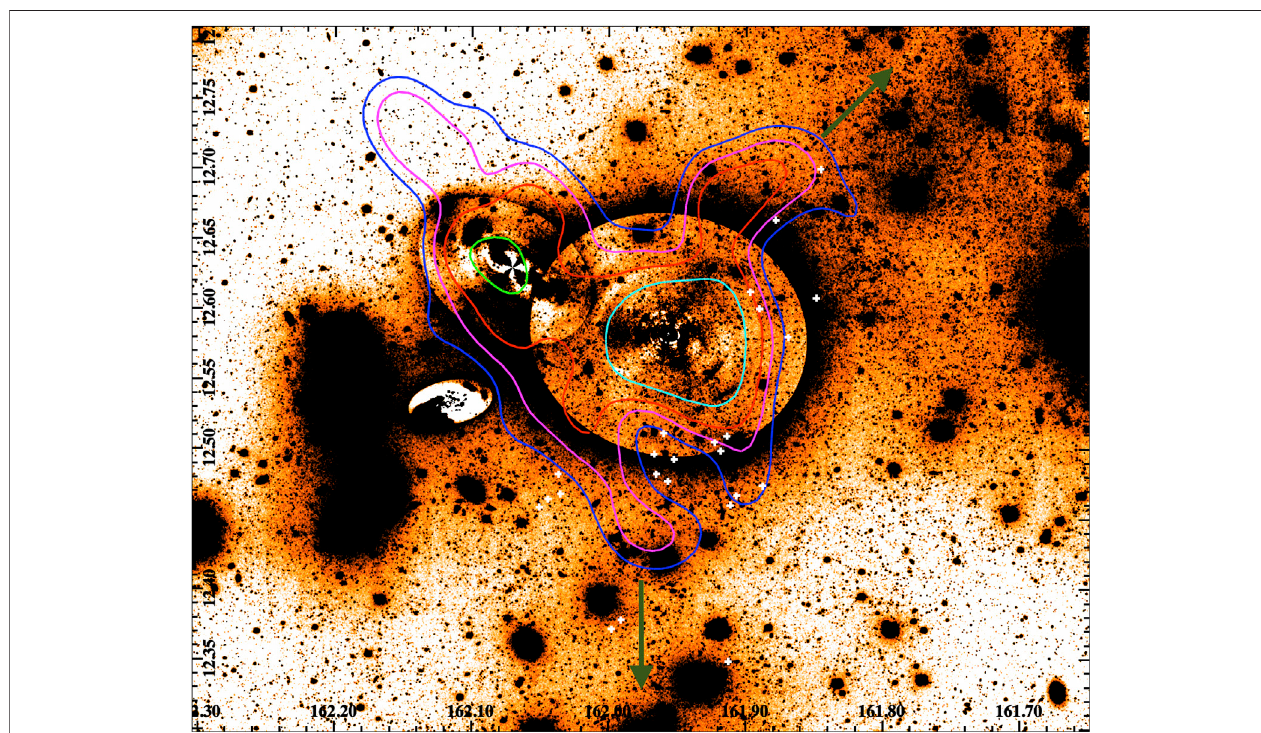
FIGURE7 | Residualimage ofthe LEO Ipair inthe g band, where the brightest regions ofthe group memberswere subtracted from the parent image (see Section 3.4). The image is 0.64×0.50 degree, inside R ≤ R lim , where the IGL is computed. The two green arrows indicate the directions of the two streams that come out of the analysis of the IGL map (for details see Section 4). The solid coloured lines indicate the iso-density contours of the GCs distribution (see Section 4.1). The white crosses mark the PNe obtained by Hartke et al. (Hartke et al., 2020), which overlap with the two streams.